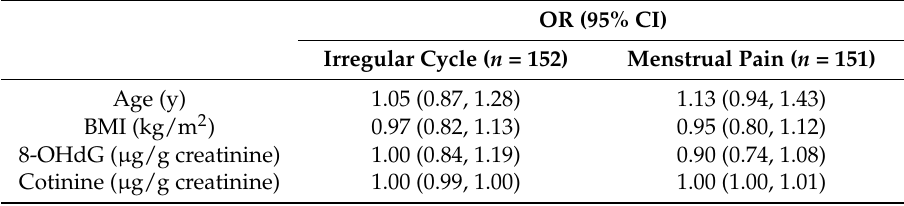
Figure 2. Association between urinary 8-OHdG concentration and menstrual cycle characteristics: ( a ) regularity and ( b ) menstrual pain ( n = 182). Table 2. Odds ratios and 95% CI for having irregular cycles and menstrual